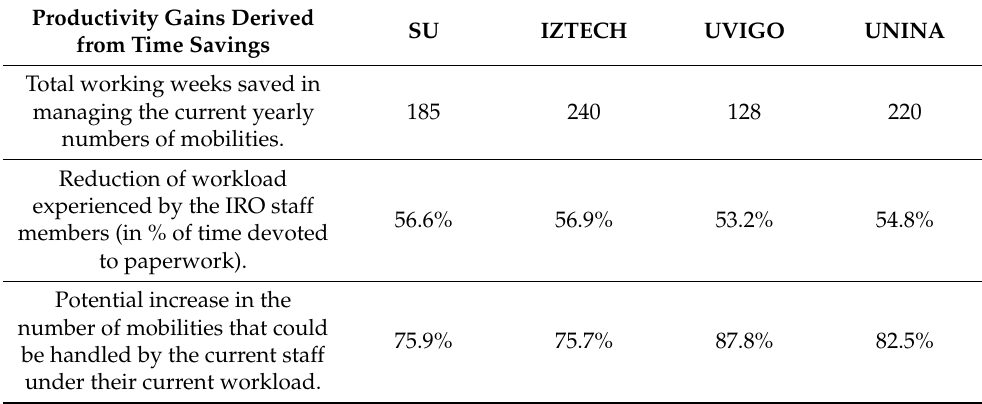
Table 5. Overall savings foreseen for the four surveyed HEIs as a result of the digitalisation of mobility